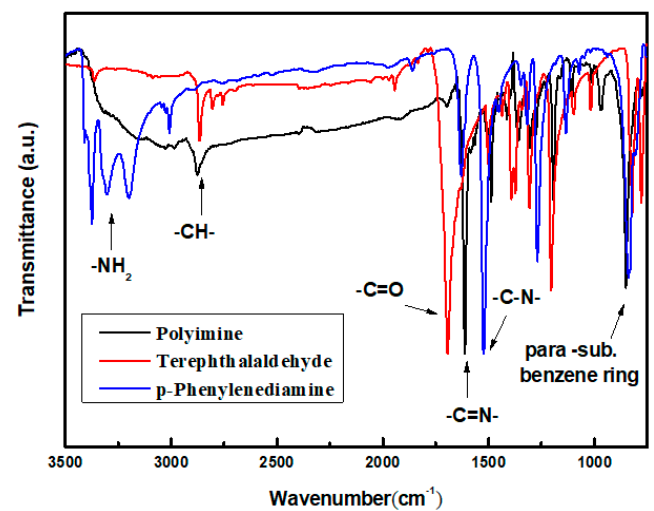
Figure 1. IR spectra of PDA, TPAl, and PIM.